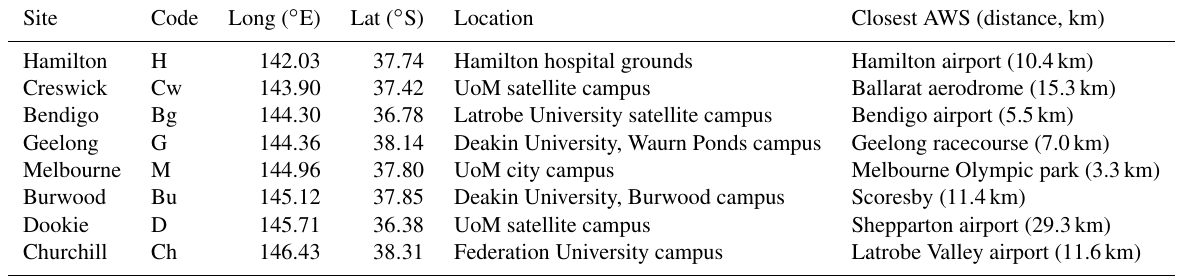
Table 1. Locations of the Burkard pollen sampling network in Victoria arranged west to east, and their nearest automatic weather station (AWS). Code refers to site names within figures of this paper. UoM refers to the University of